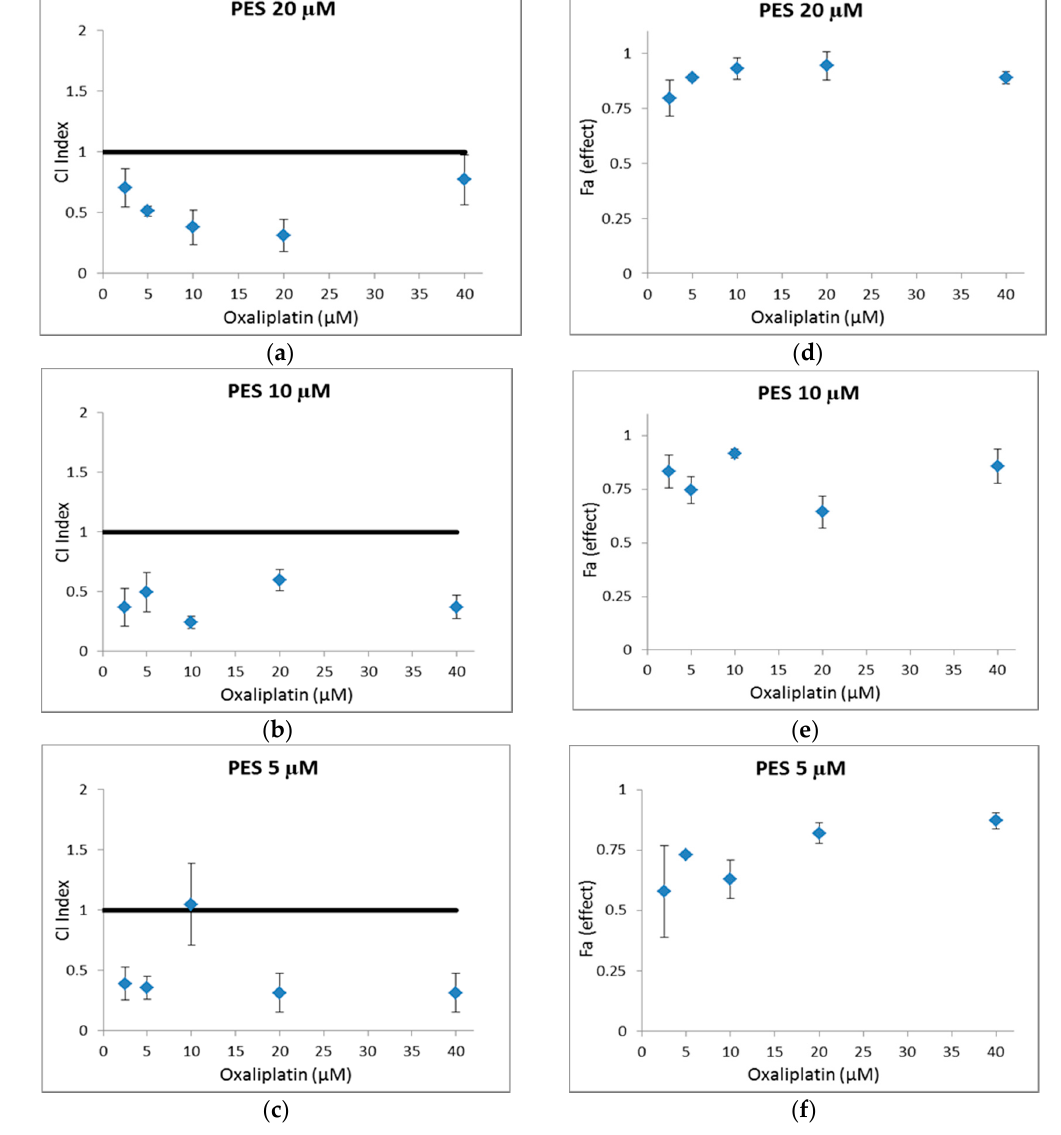
Figure 3. CI values for pifithrin- μ (PES) at 20 μ M ( a ); 10 μ M ( b ) and 5 μ M ( c ) in combination with 2.5, 5, 10, 20 and 40 μ M oxaliplatin against HT29 cells. CI (Combination index) is a